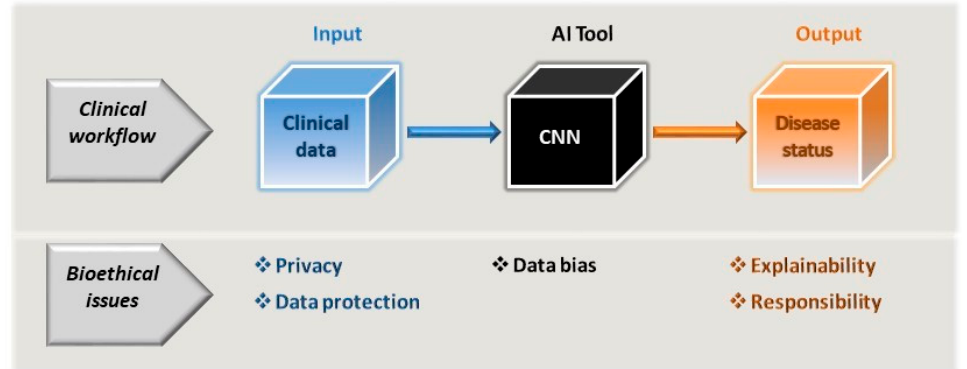
Figure 2. As part of the clinician’s workflow and decision-making process, the AI tools driven by CNNs can be considered a black box subject to data bias. As such, the AI tool itself cannot be allowed to introduce bias through its very design or to exacerbate any bias inherent to the input data used. The model input is essentially the patient’s clinical (or clinically related) data, which is subject to the constraints of privacy and data protection. As a consequence of using the tool, the clinician will extract information regarding the patient’s disease status and they must be in a position to be able to accept and explain the output of the model, and along with the healthcare providers, accept the same level of responsibility for this as would be expected in any clinical workflow.